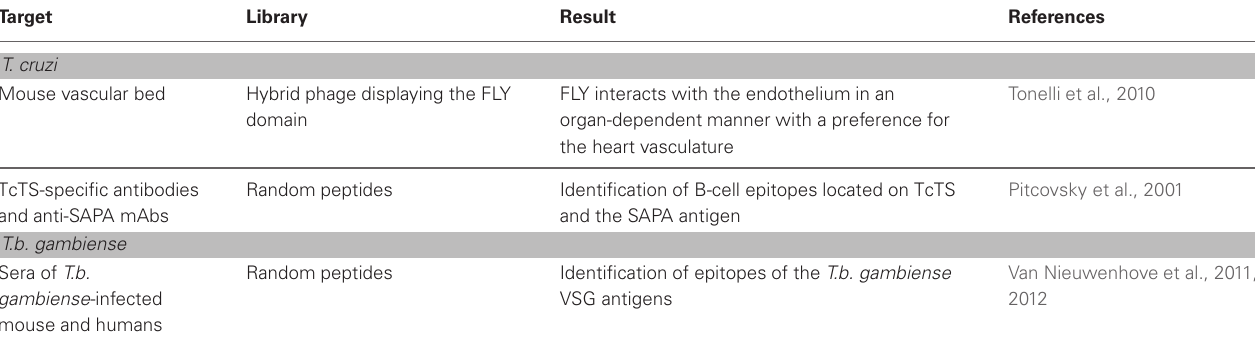
Table 5 | Summary of phage display applications in research with T. cruzi and T.